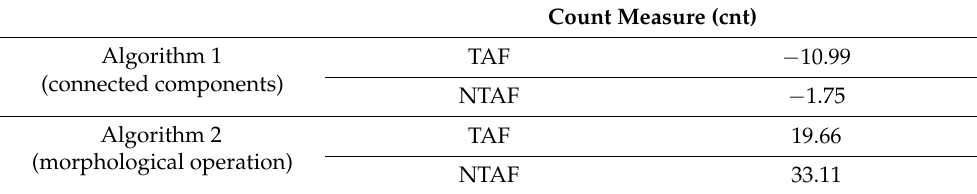
Table 2. Difference between ground-truth treetops and detected treetops (cnt), where positive values indicate detected treetop underestimation and negative values indicate